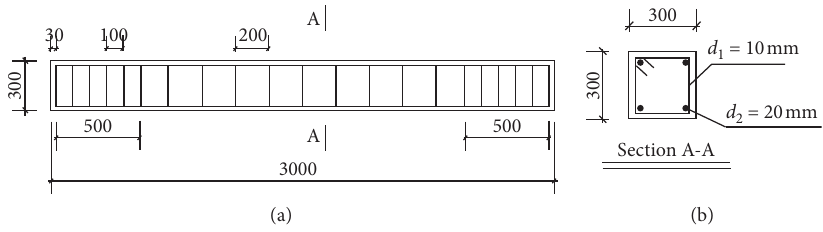
Figure 1: Geometry and reinforcement of the column. (a) Reinforcement configuration. (b) Cross section. Table 1: Material properties for steel reinforcement and concrete.